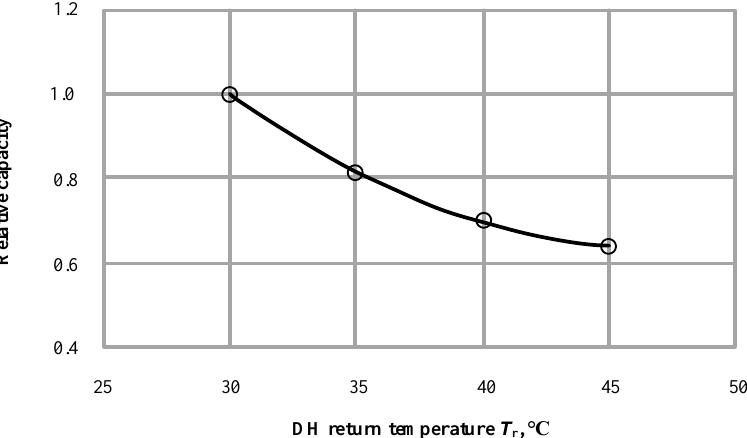
Fig. 6. Capacity decrease of direct contact heat exchanger depending on return temperature